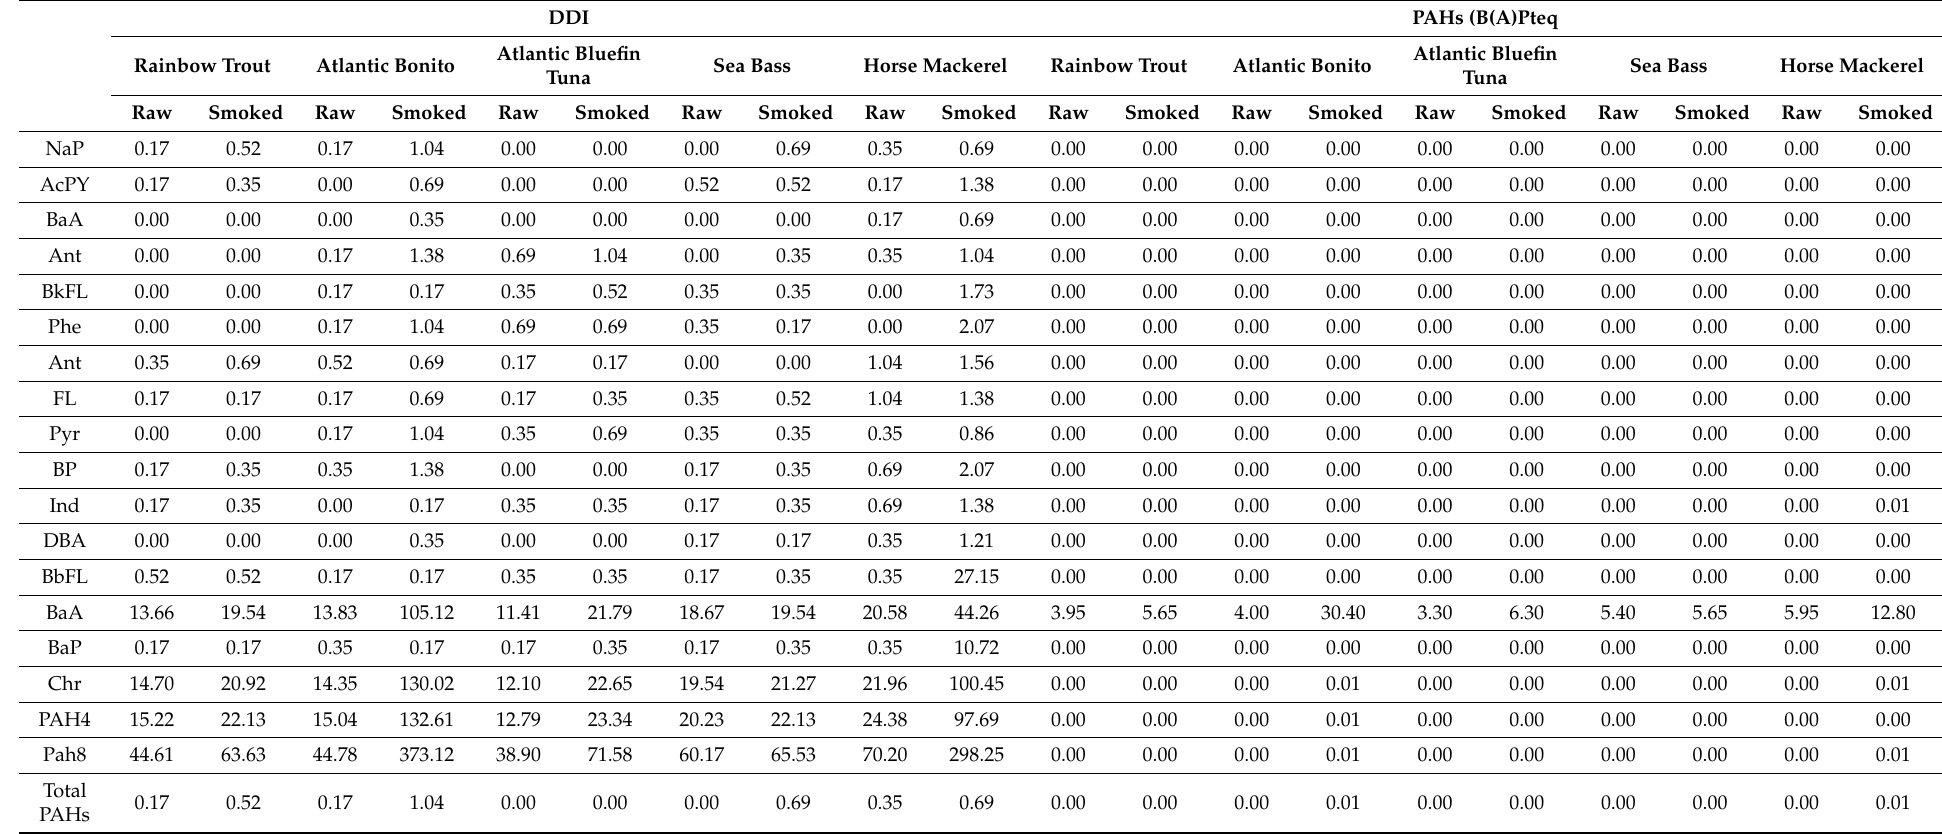
Table 5. Health Risk assessment of